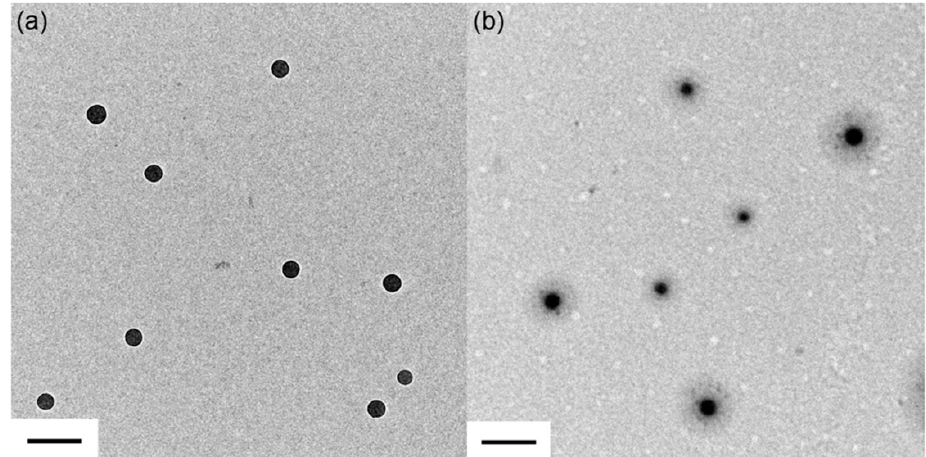
Figure 2. Transmission Electron Microscopy (TEM) images of ( a ) crosslinked polystyrene (PS) core; ( b ) PS@PSS hairy nanoparticles. The bar is 200 nm.